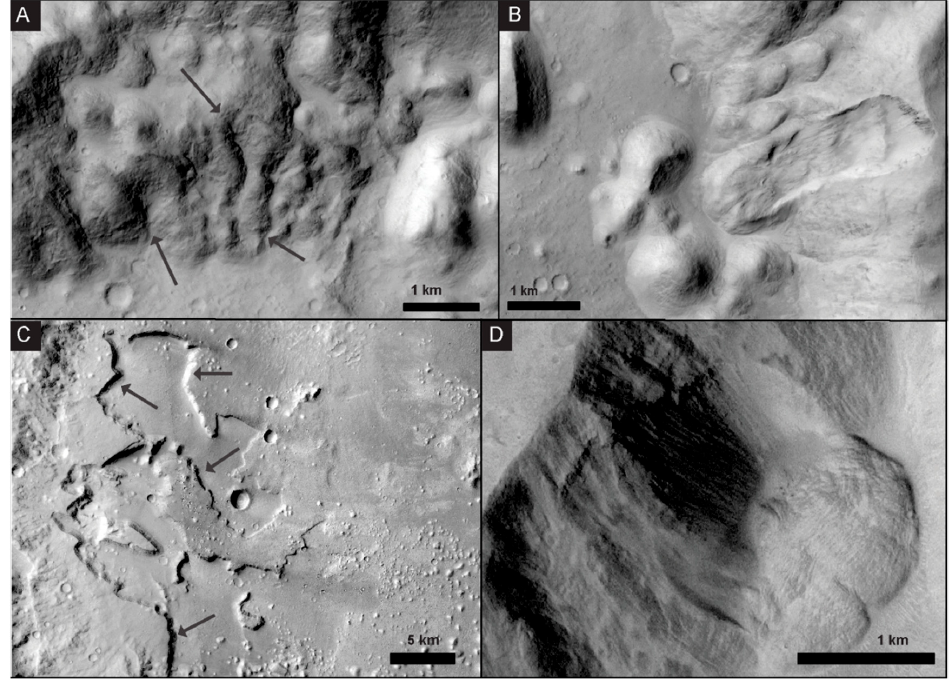
Figure 5. Erosion across Galilaei crater. ( A ) Channels (arrows) are commonly carved into the Galilaei crater rim and could have been pathways for water to fill the paleolake. ( B ) A landslide in the wall of Galilaei crater with the head scarp and toe still intact. The toe of the landslide maintains a flat-topped blocky morphology seen in many chaos terrain blocks within the crater. ( C ) Steep-walled depressions in the western Galilaei crater interior. Steep scarps (arrows) line depressions in a region largely devoid of chaos terrain blocks. ( D ) A landslide in the steep walls of the Tana Vallis outflow channel. See Figure 3 for image locations.